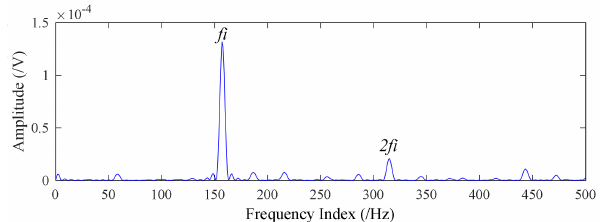
Figure 18. The diagonal slice spectrum of the original